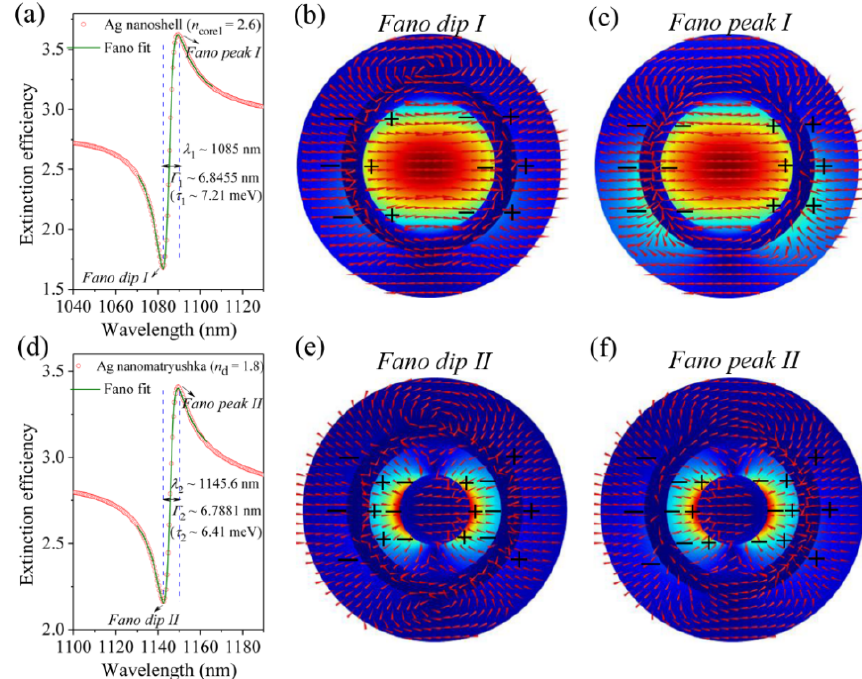
Figure 5. ( a , d ) Fano fitting (olive lines) the calculated extinction efficiency spectra ( a 1 ) for an Ag nanoshell ( r core1 = 150 nm, n core1 = 2.6) and an Ag nanomatryushka ( r core2 = 80 nm, d = 70 nm, n d = 1.8), respectively. ( b , c , e , f ) show the electric-field vector distributions of the dipolar cavity plasmon and the hybrid modes at the Fano dip (peak) I and Fano dip (peak) II labeled in ( a ) and ( d ), respectively. Red arrows represent field direction and colors show field intensity. Black signs “+” and “ − ” stand for positive and negative charges, respectively.